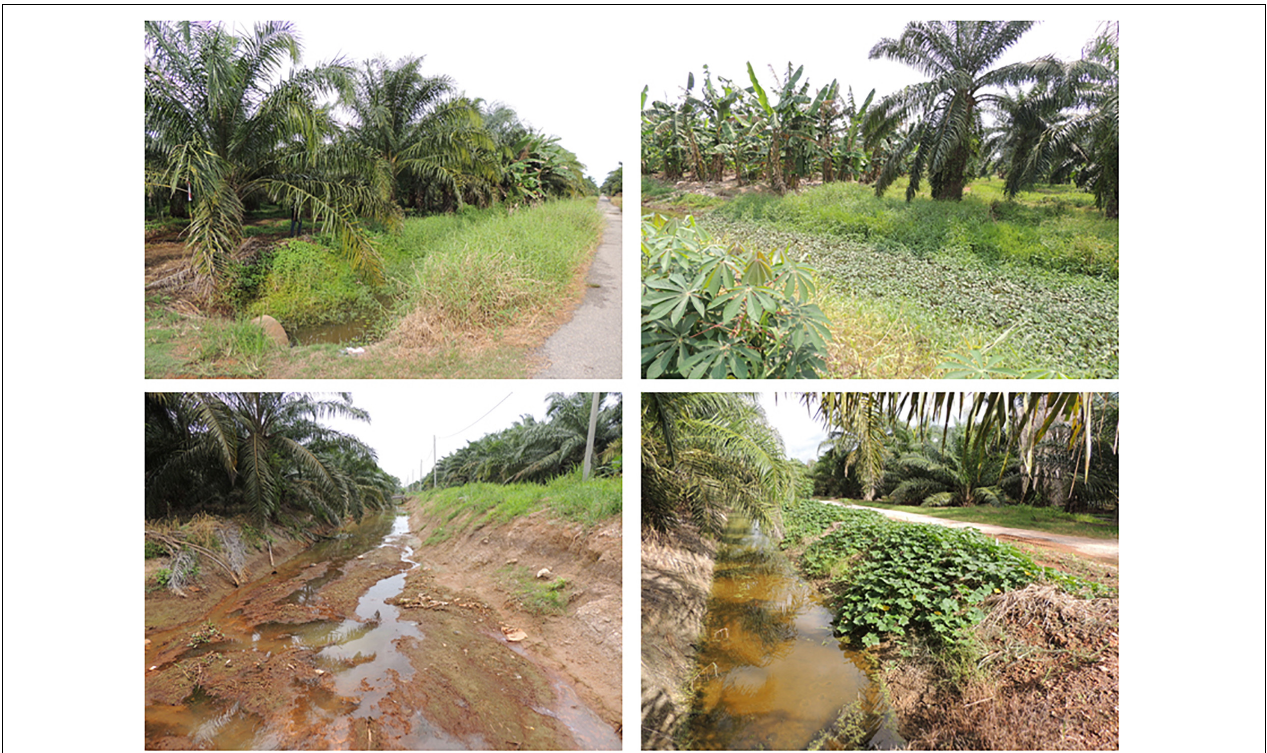
FIGURE 2 | Typical man-made waterways at the study area. These waterways are built in oil palm smallholdings for flood-control and irrigation. Vegetation cover including non-aquatic and semi-aquatic weeds characterizes the waterways and provides places to perch from which Odonata can take off to capture prey and as a vantage point to patrol a